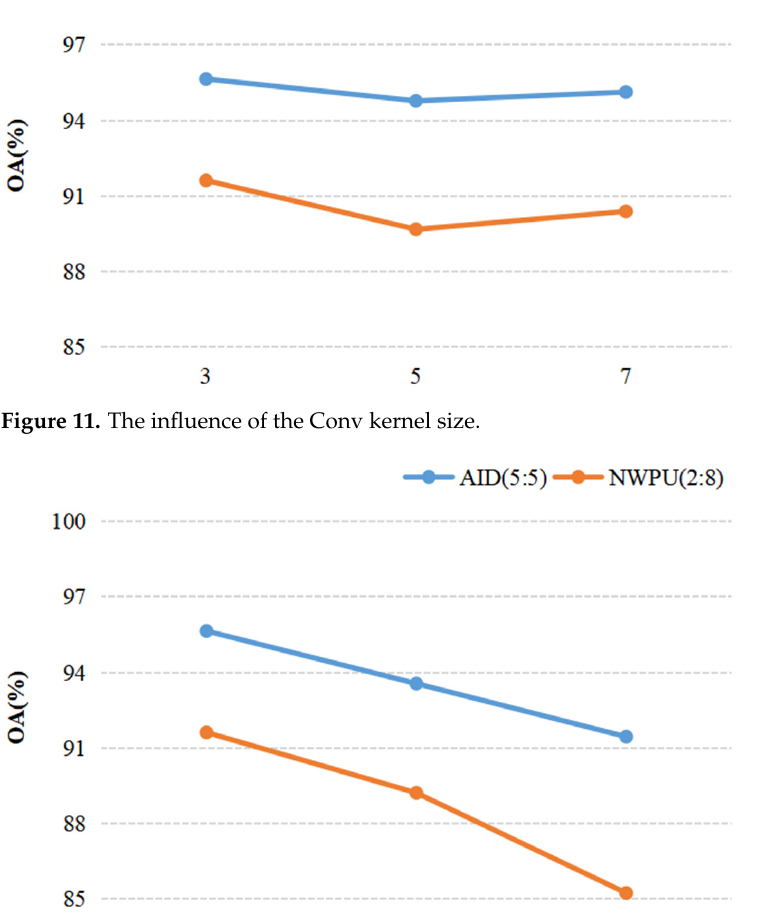
Figure 12. The influence of the pooling kernel size.